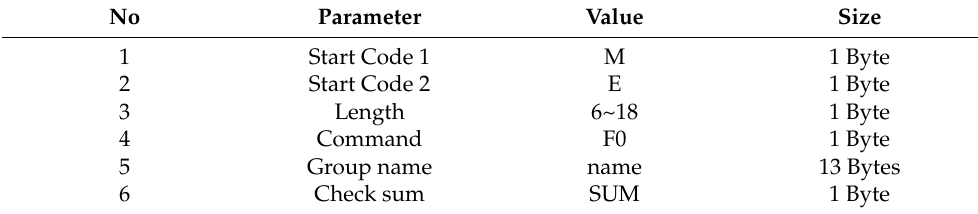
Table 4. Group name setting protocol.